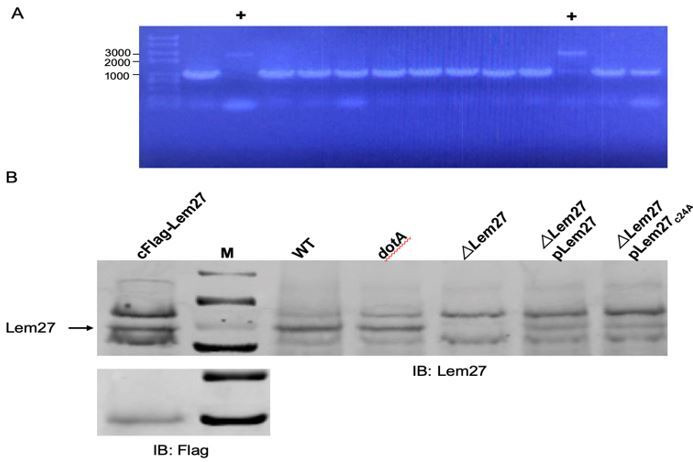
Flag-tagged Lem27 expressed from a knockin L. pneumophila strain can be detected by Lem27 antibodies but not by Flag antibody.A construct harboring Flag-lem27 on a suicide plasmid was used to introduce tagged lem27 into the ∆lem27 strain make the knockin strain in which Flag-Lem27 will be expressed from its cognate promoter. A. Bacteria harboring Flag-lem27 were identified by colony PCR. The two strains harboring knocked in gene were marked by “+”. B. Expression of Lem27 or Flag-Lem27 in relevant L. pneumophila strains. Total protein lysates of the indicated strains resolved by SDS-PAGE were detected by our Lem27-specific antibodies (top panel). Note the presence of a band in all strains expressing Lem27, including strain cFlag-Lem27, with the exception of strain ∆lem27 (5th lane). Flag-Lem27 was not detected by the Flag antibody (lower panel).